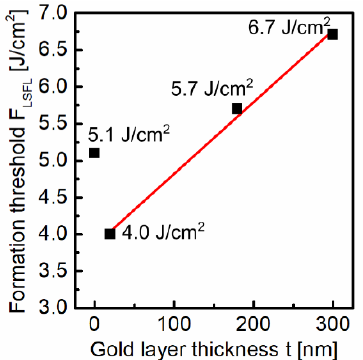
Figure 3. Threshold fluence F LSFL for the formation of LSFL as a function of the gold layer thickness t determined from the corresponding SEM micrographs (see Figure 2) using the method proposed by Liu [29]. The red solid line guides the eye.